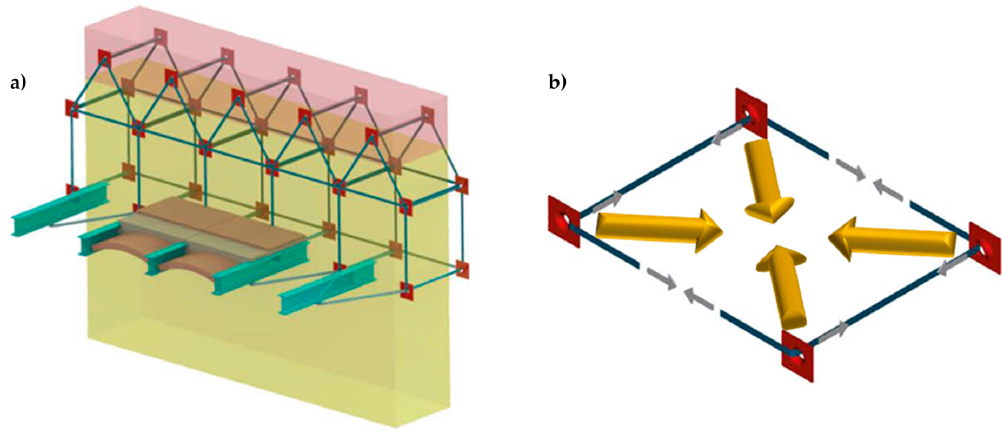
Figure 4. The CAM system: ( a ) the three-dimensional net of steel ribbons and ( b ) how a pre-tensioned steel ribbon compresses the masonry.